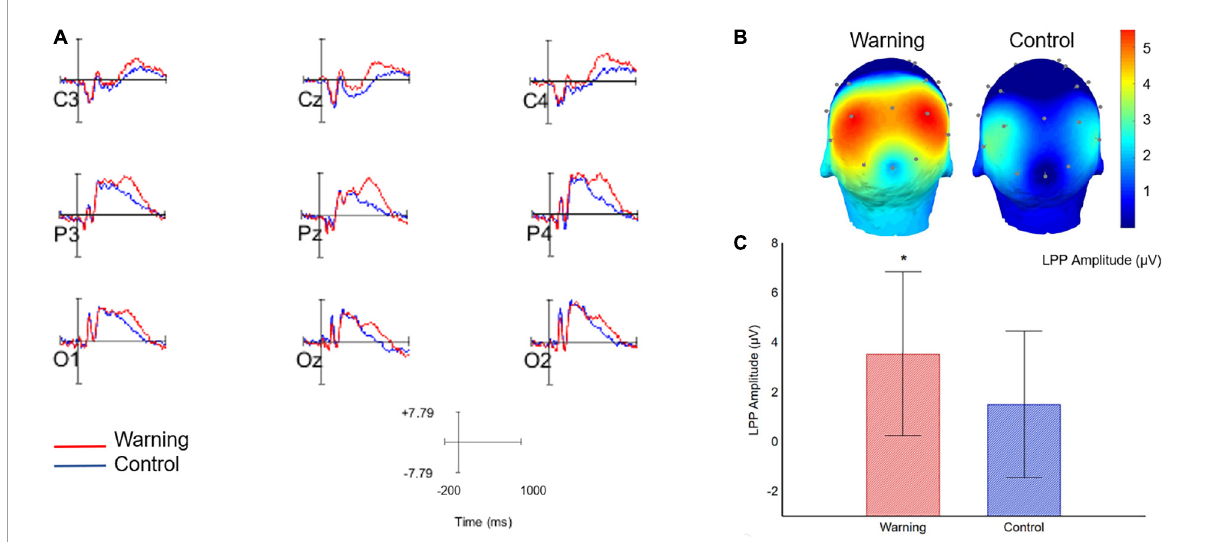
FIGURE2 (A) Grand averages showing event-related potential waveforms during the warning (red line) and control conditions (blue line) across posterior electrodes (C3, Cz, C4, P3, Pz, P4, O1, Oz, O2). The grand-average ERP plots included the segment during 200 ms pre-UPF picture onset (baseline period) to a 1000 ms post-UPF picture onset. Positive voltages are plotted upward. (B) Topographical maps of the scalp (3D head, posterior view) showing the voltage distribution across the posterior electrodes during the warning (left) and control (right) conditions in the time window of 400–800 ms after UPF picture onset. The colormap changes from blue to red, the more positive-going are the waveform deflections over the scalp, measured in micro voltages ( µ V). Since the LPP is a waveform with positive deflection, it can be observed that it is greater during the warning condition (warm color) than during the control condition. LPP was observed at the posterior electrodes, in agreement with the literature (25). (C) Bar chart showing LPP amplitudes during the 400–800 ms time window analysis in the posterior electrodes (voltages were averaged across electrodes) in warning condition (red bar) and control condition (blue bar). * p <